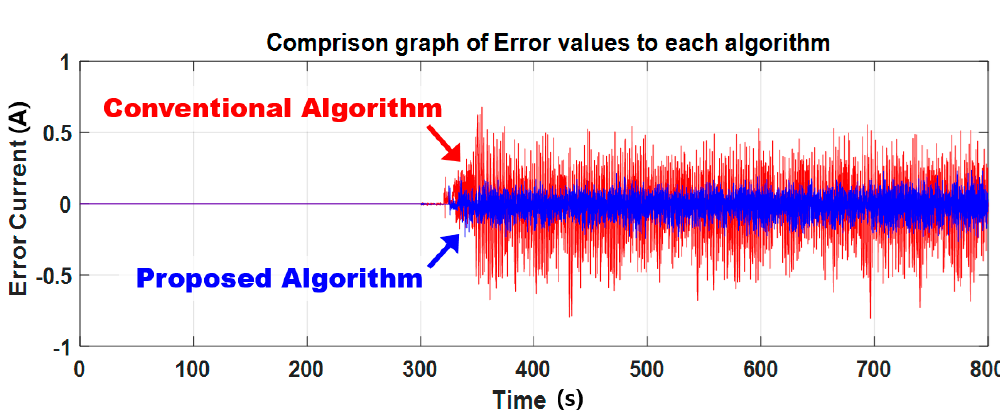
Figure 15. Error compared to reference value to each algorithm. Table 5. Performance Index of each algorithm.